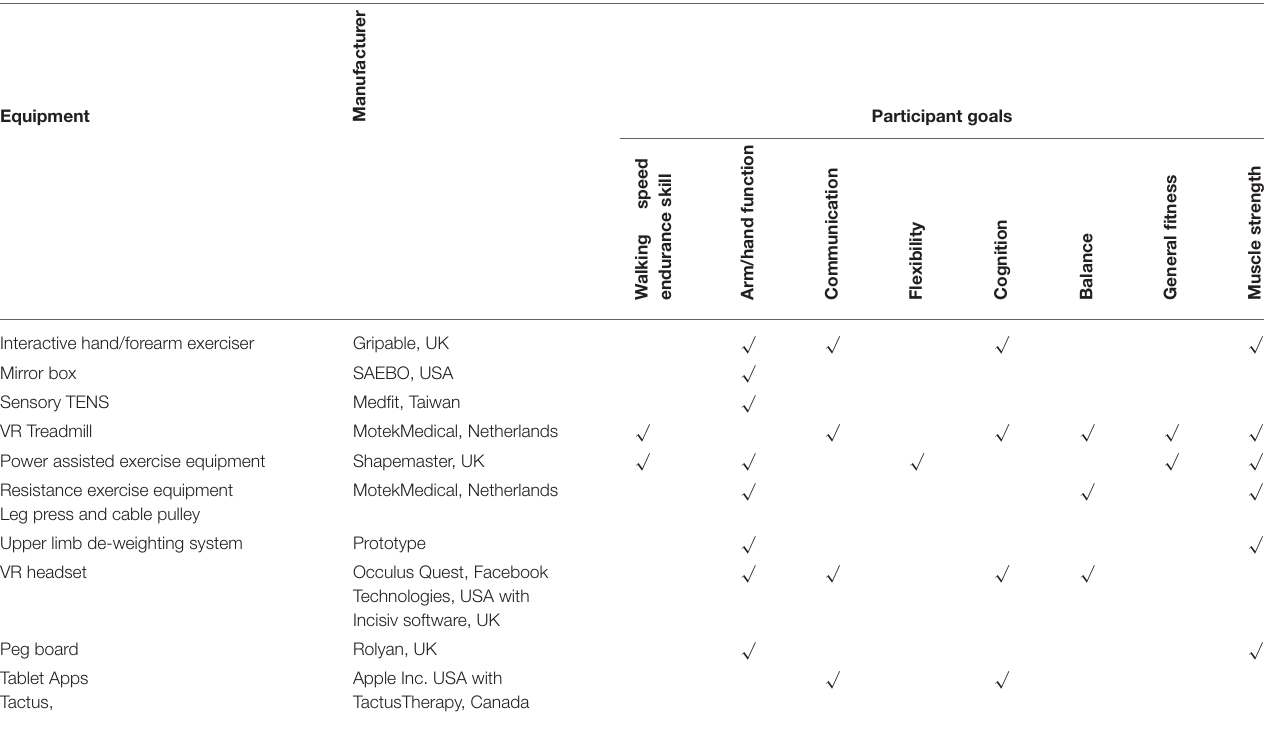
TABLE 1 | Details of equipment used and corresponding participant